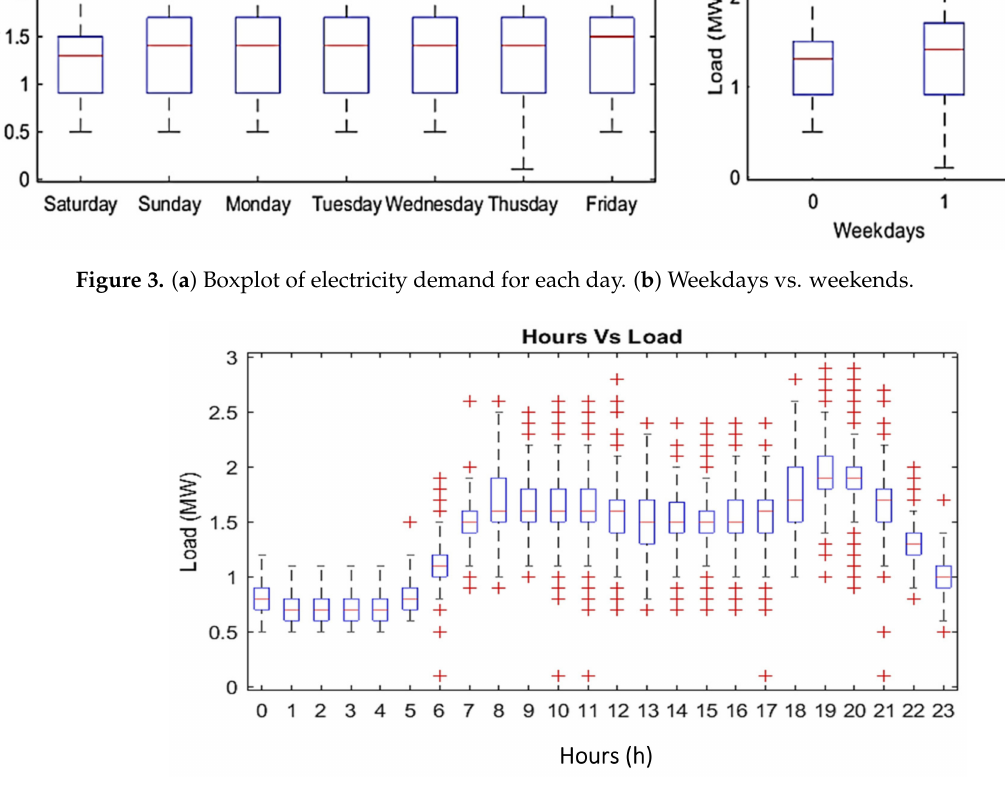
Figure 4. Box plot of electricity demand for each